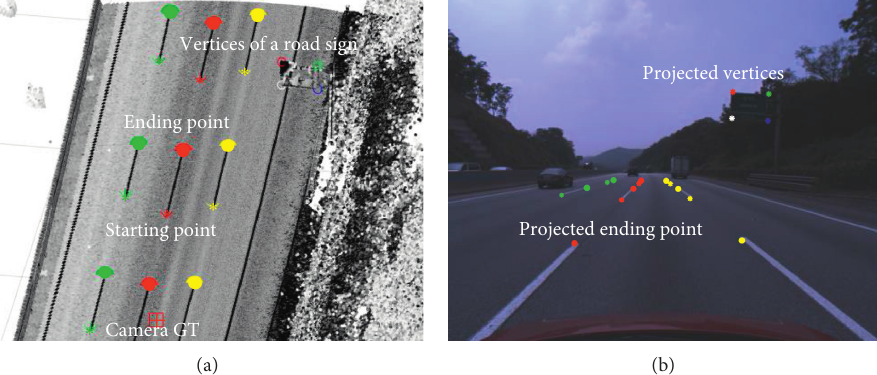
Figure 9: The camera global position calculated from the MMS and the projected global points of lane endpoints and road sign vertices: (a) lane endpoints and road sign vertices on the Lidar cloud points; (b) lane endpoints and road sign vertices projected on an